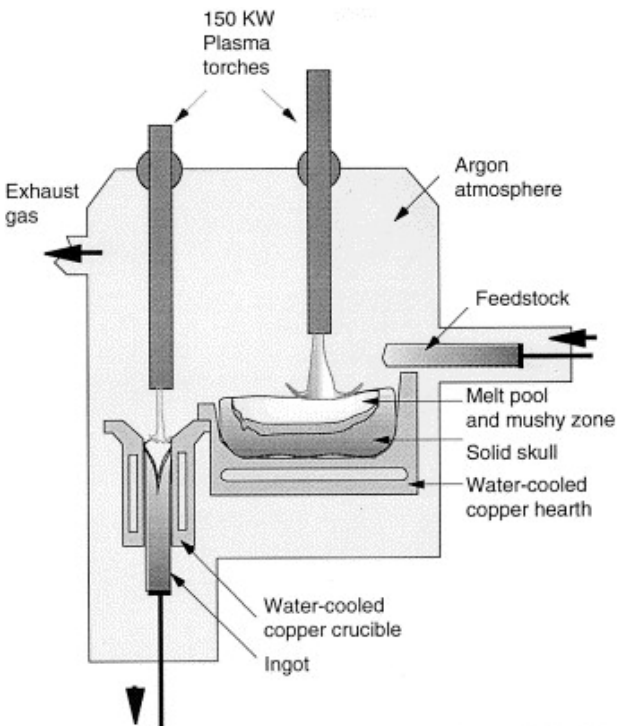
Figure 10. Low-pressure arc plasma. Reprinted from [43] with permission from Elsevier 1996.